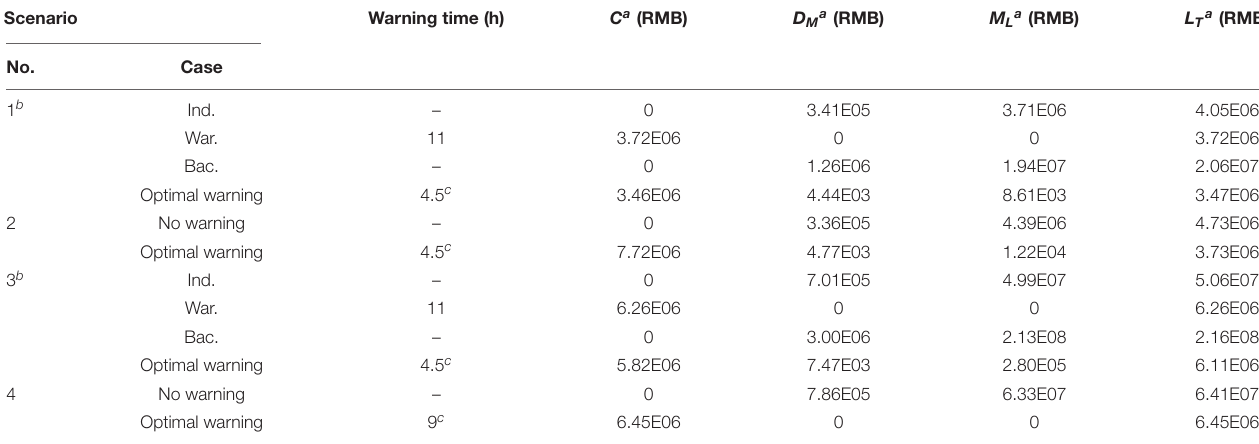
TABLE 7 | Risk-based warning decision making in Beichuan County under deterministic dam breaching time. Scenario Warning time